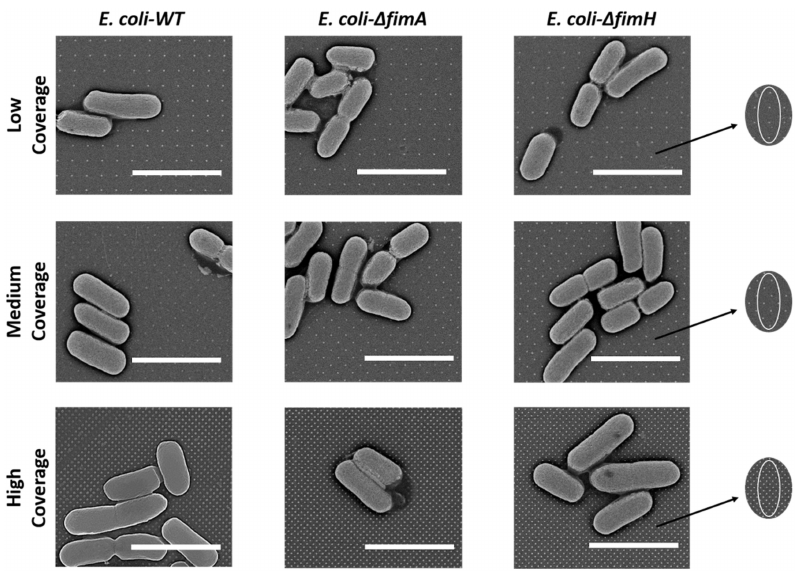
Figure 5. SEM images of tested bacteria. Fimbriae were not visible in all cases. Black arrows point at the theoretical position of bacteria (white oval) on the nanopattern. Scale bars = 2 µ m.